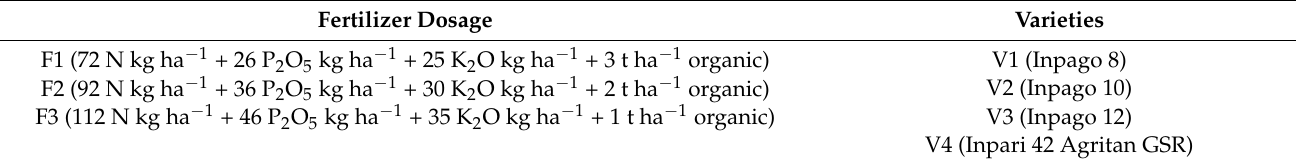
Table 1. Treatments of fertilizer dosage and varieties of the study in karst dryland, Gunungkidul, WS 2019/2020. Fertilizer Dosage